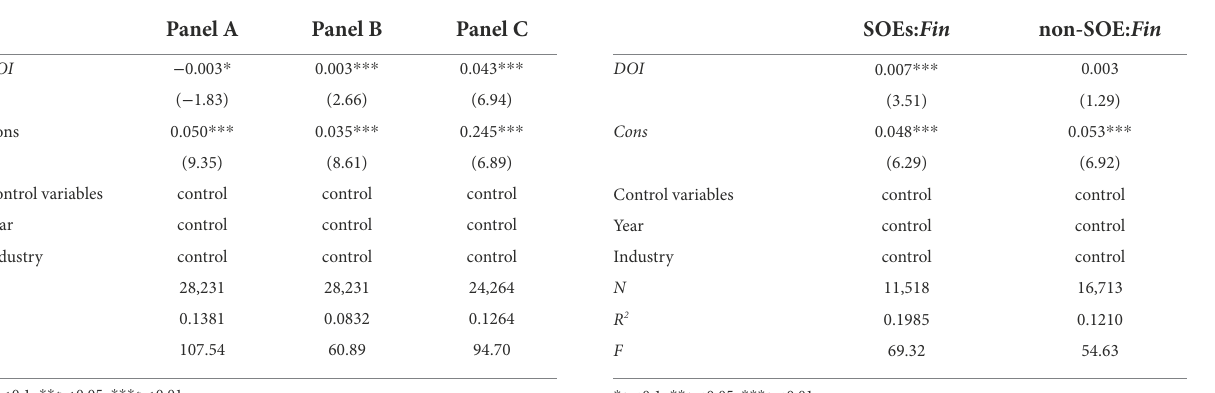
TABLE 9 Sample regression results of different property rights.